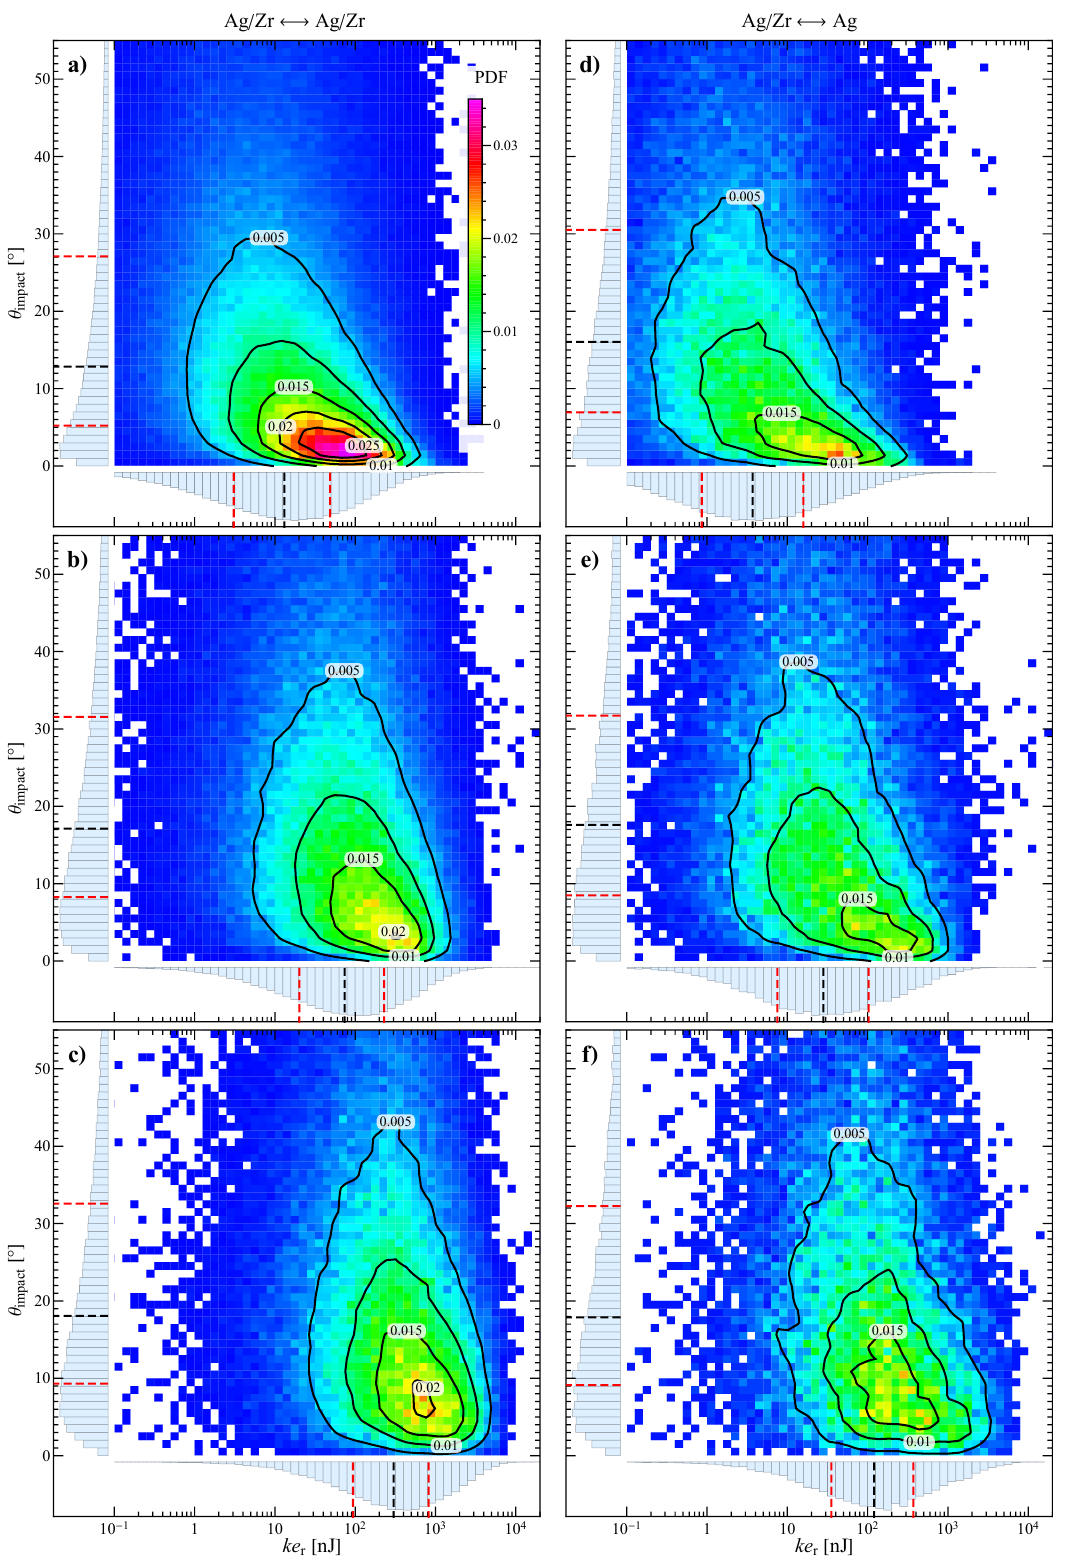
Figure 5. Map and contours of the joint probability density function for impact angle and relative kinetic energy at ( a , d ) 300 rpm, ( b , e ) 600 rpm, and ( c , f ) 900 rpm for the impacts between all the particles (left column) and those involving at least an Ag particle (right column). On the edges of every map the marginal probability density functions and the corresponding quartiles are also shown (the dashed red lines representing the first and third quartiles and the dashed black line the